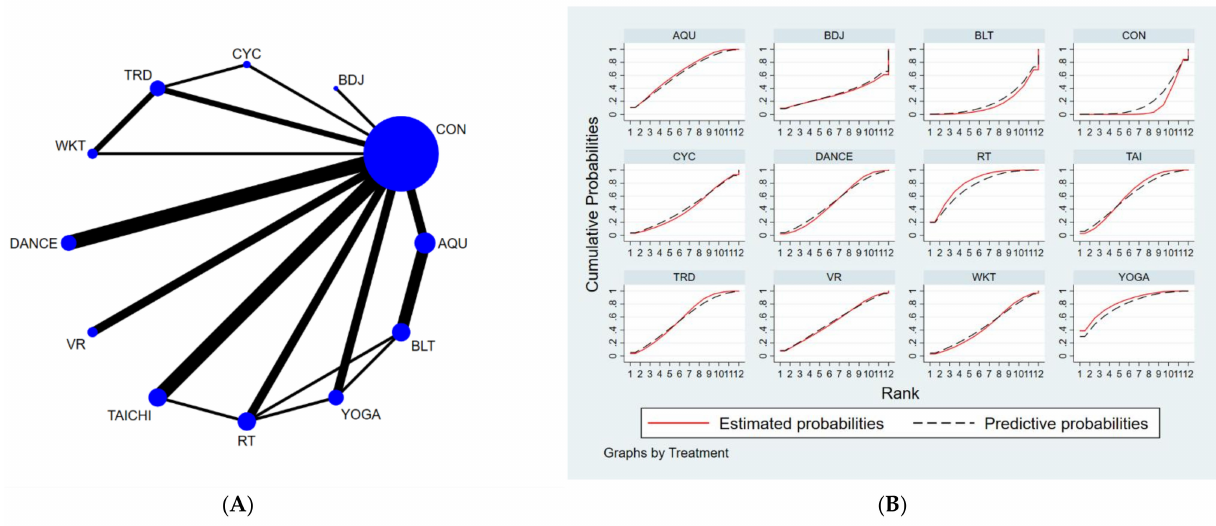
Figure 3. ( A ) NMA figure for TUGT, ( B ) SUCRA plot for TUGT.